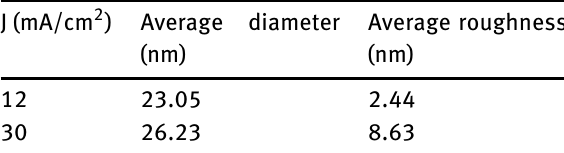
Table 2: The AFM results of PS samples at J=12, 30 mA/cm 2 . J (mA/cm 2